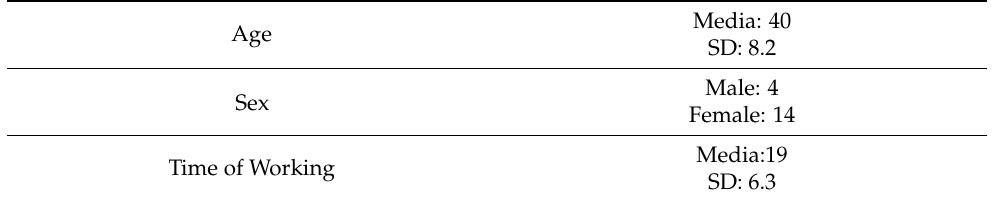
Table 3. Characteristics of the participants.